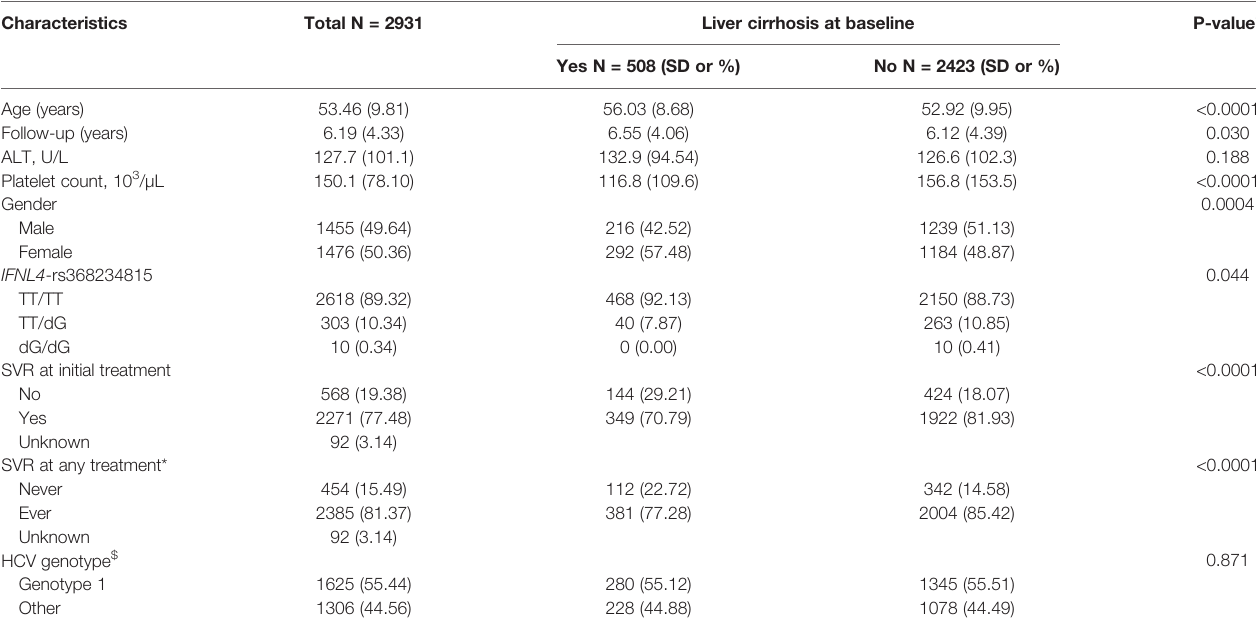
TABLE 2 | Baseline characteristics of HCV-infected patients in the REVEAL II cohort, Taiwan.